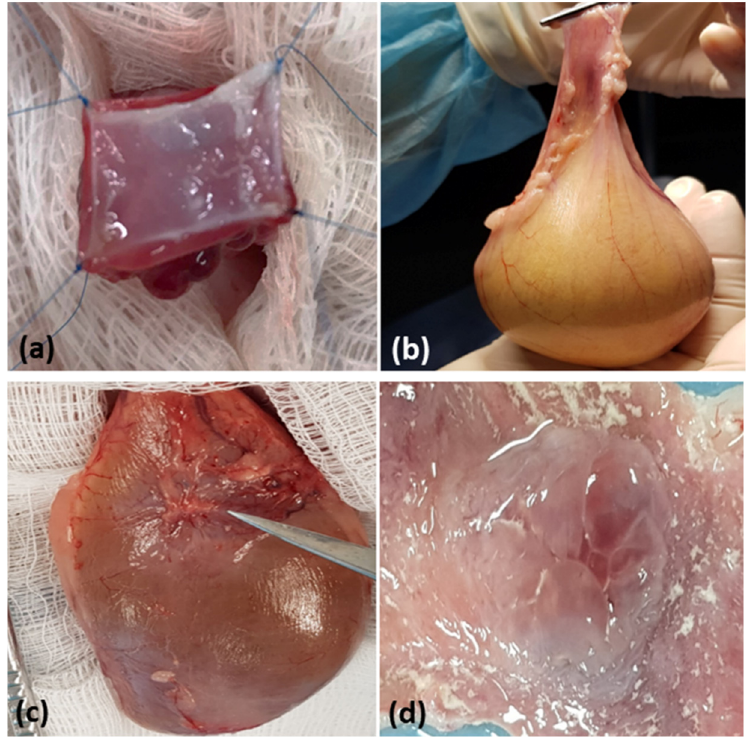
Figure 2. Macroscopic aspects of the urinary bladder. ( a ) Surgical implantation of the scaffold in the total wall. ( b ) Euthanasia and surgical removal of the urinary bladder for analysis. ( c ) The tip of the scissors indicates the scaffold implant point. ( d ) Macroscopy of the scaffold implanted on the luminal surface of the bladder.